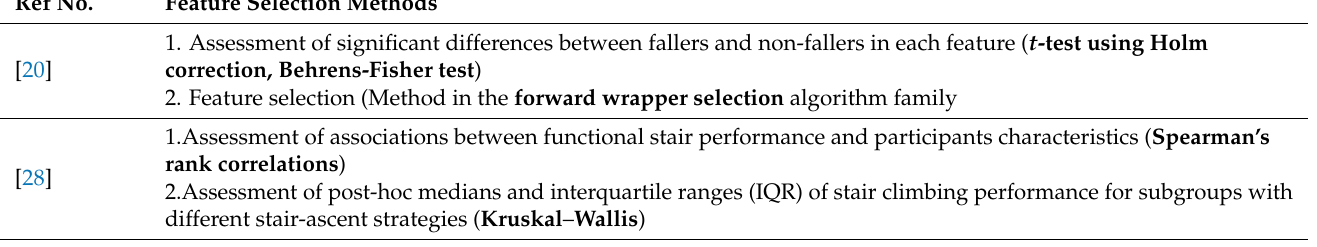
Table A4. Complimentary information for the feature selection methods in Table 6. Ref